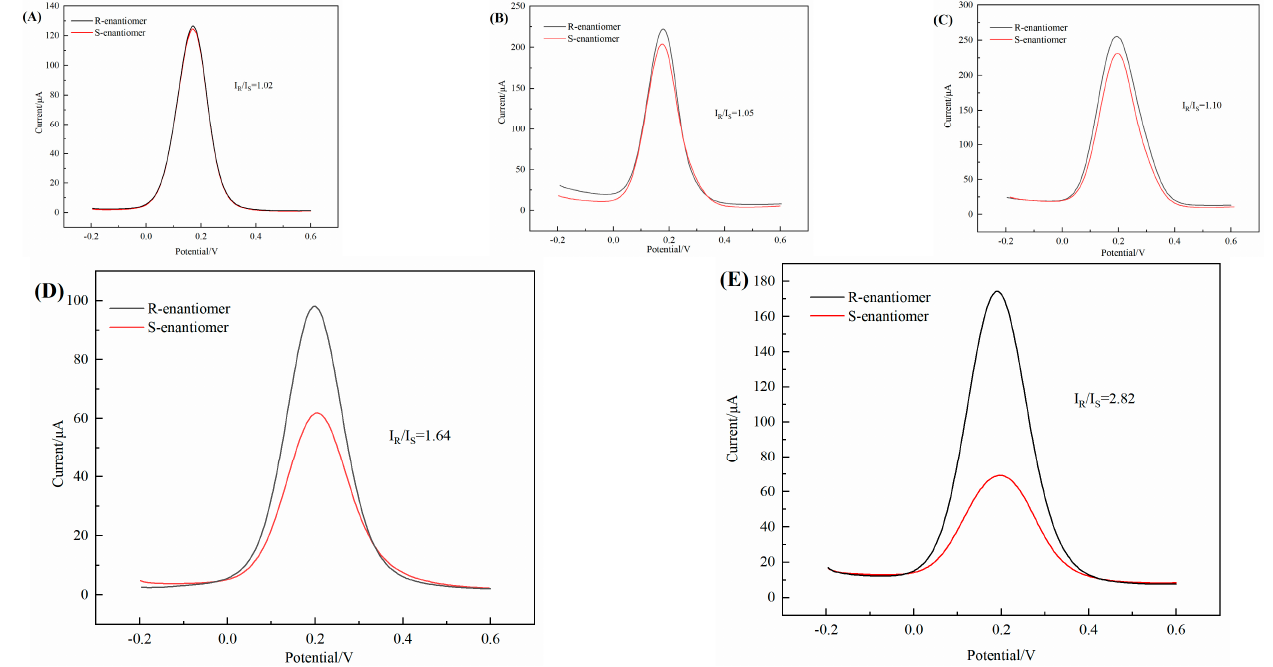
Figure 7. DPV curves of 0.05 M R–enantiomer or S–enantiomer at the ( A ) bare GCE, ( B ) 3D– rGO/GCE, ( C ) 3D–rGO–CS/GCE, ( D )CS–BSA/GCE, and ( E ) 3D–rGO–CS–BSA/GCE were recorded in 0.1 M KCl containing 5 mM [Fe(CN) 6 ] 4 − /3 − solution,